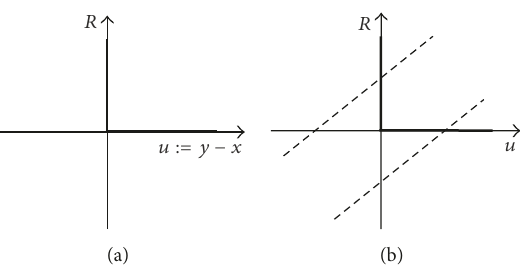
Figure 2: Graph of the mapping expressed via (1d) (a) and graphical solution leading to (4b)